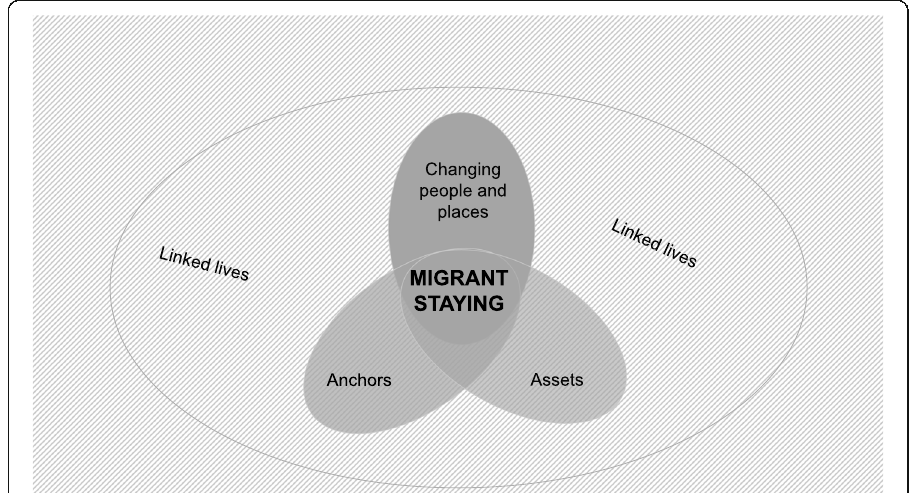
Fig. 1 Influences shaping temporalities of migrant